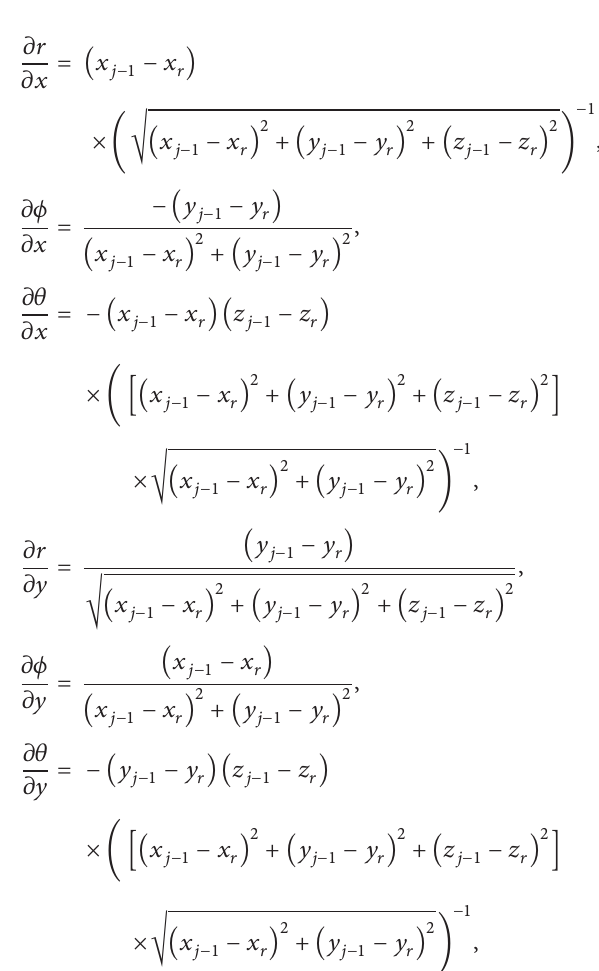
Figure 7: Beam pointing error correction for roll angle.